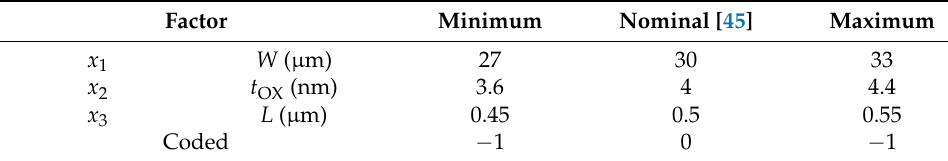
Table 1. Input factors levels in the performed